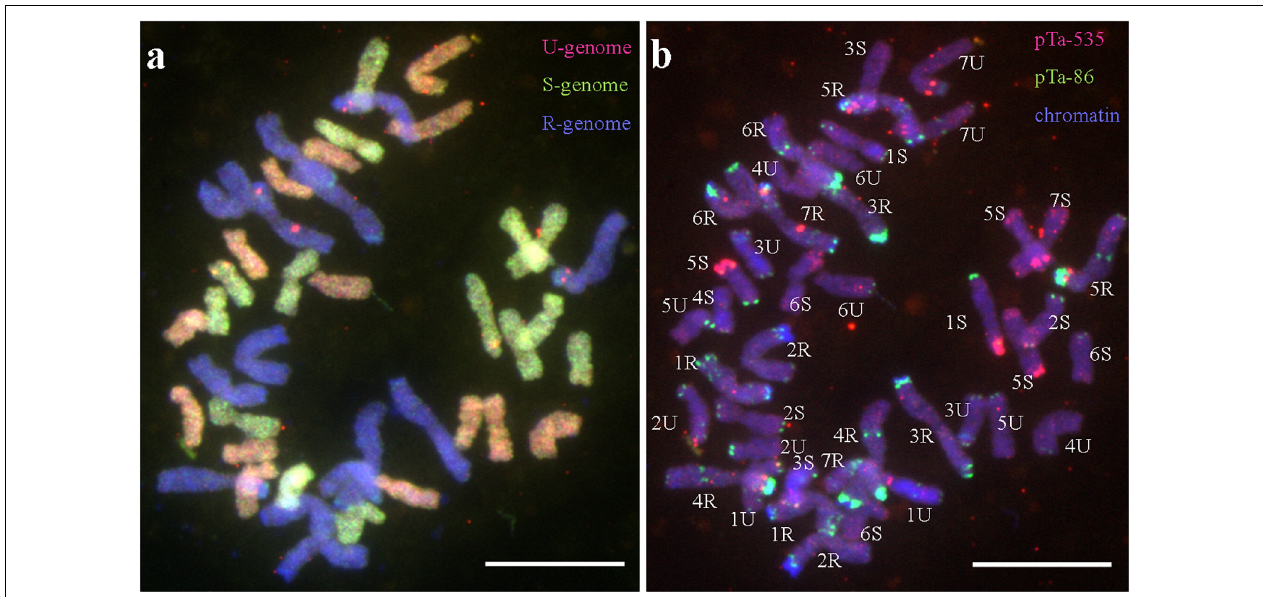
FIGURE 1 | Flourescence/genomic in situ hybridization performed on mitotic chromosomes of A. kotschyi × S. cereale amphiploid. (a) U k - and S k -genome chromosomes are labeled with Atto-550 (red) and Atto-488 (green), respectively. R-genome chromosomes labeled with DAPI (blue). (b) Probes pTa-535 and pTa-86 are labeled with Atto-550 (red) and Atto-488 (green), respectively. Chromosomes counterstained with DAPI (blue). Scale bar, 10 µ